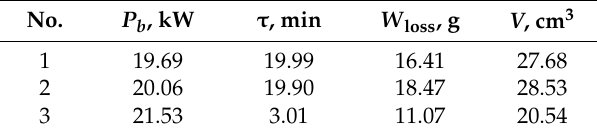
Figure 8. Pareto-optimal solutions with minimal material losses and maximal molten pool volume of electron beam melting of Ta. Table 9. Pareto-optimal solutions ( W loss , V ) and the corresponding EBM conditions.